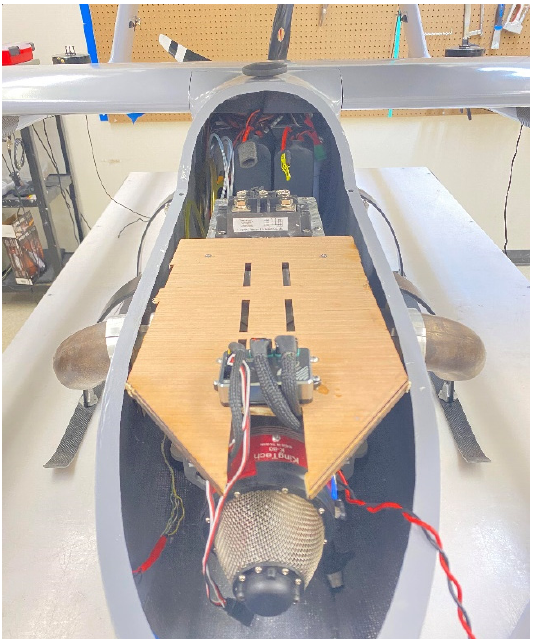
Figure 1. The 7.3 kW turboelectric system integrated into a UAS.